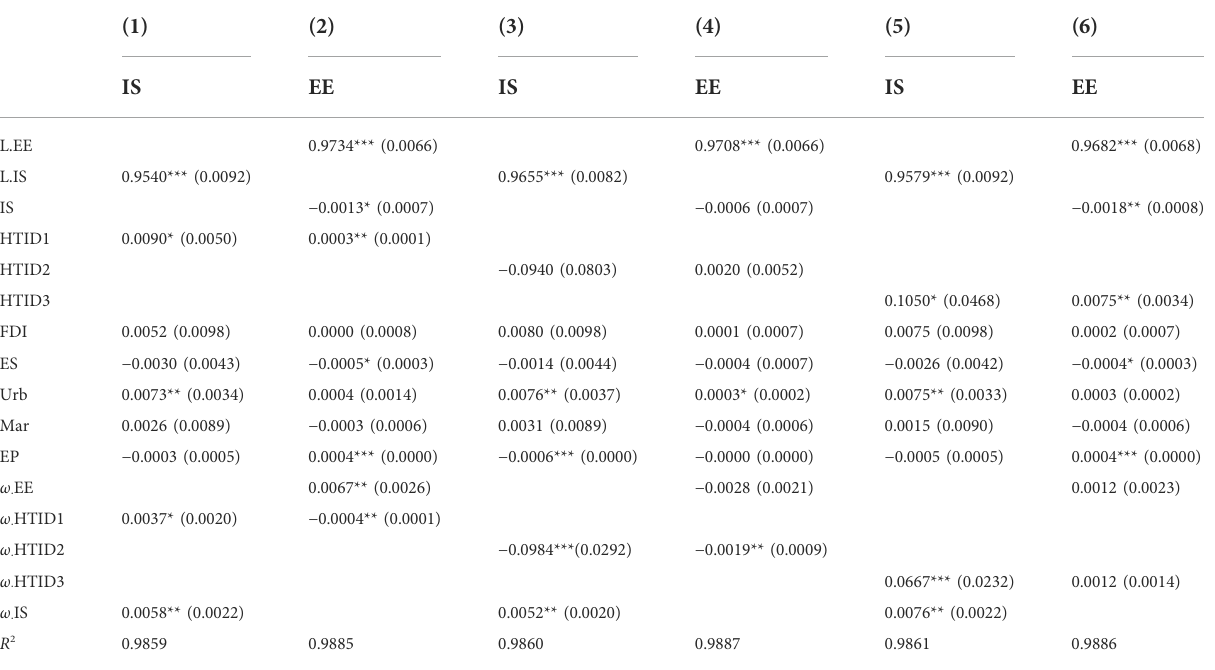
TABLE 5 Intermediary effect test of industrial